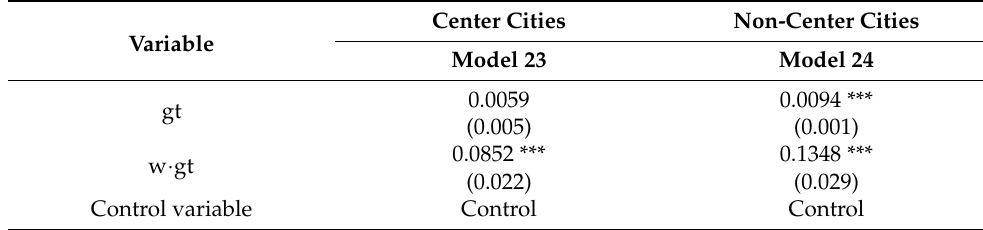
Table 11. Heterogeneity analysis results (Administrative levels).